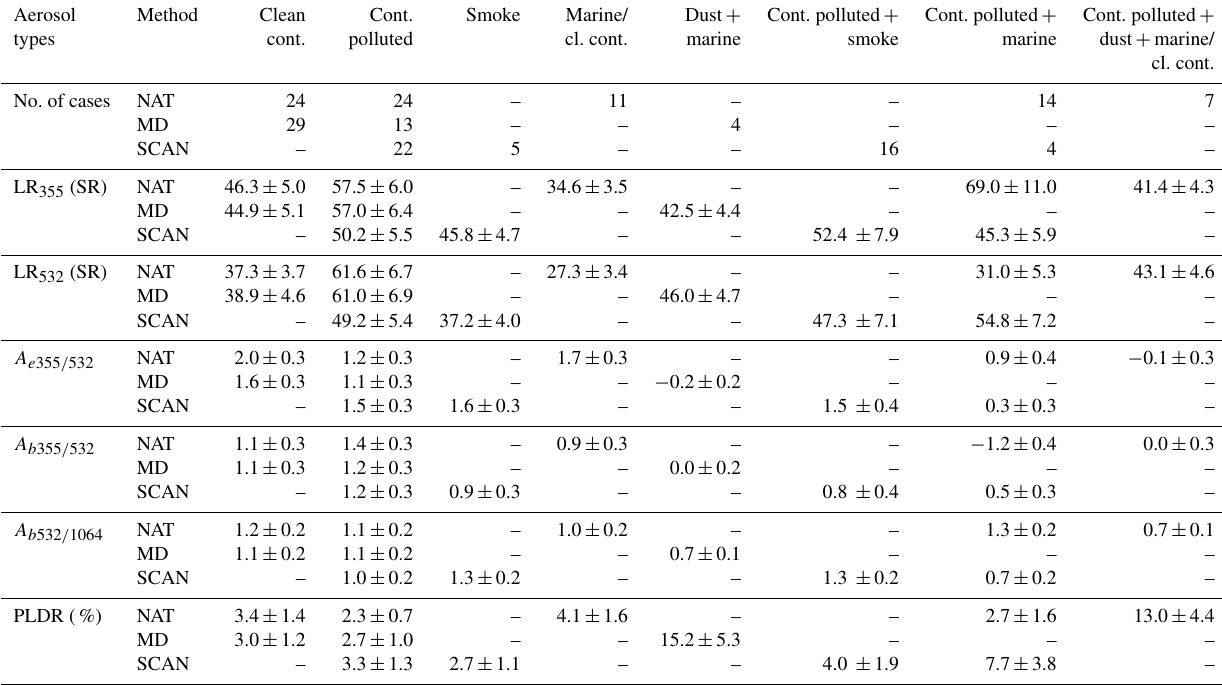
Table 4. Mean values and standard deviations of aerosol optical properties according to each classification method. Aerosol